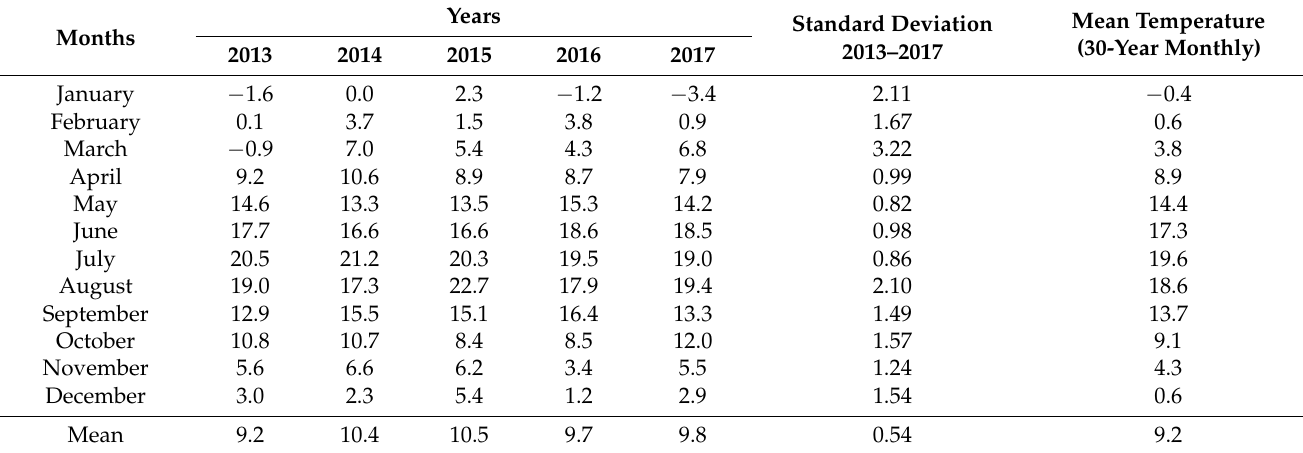
Table 2. Monthly mean air temperature ( ◦ C) over the period